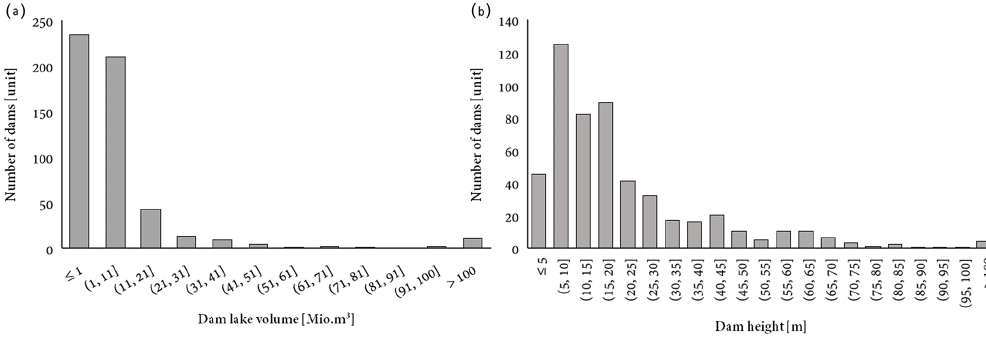
Figure 5. Lake volume (a) and dam height (b)